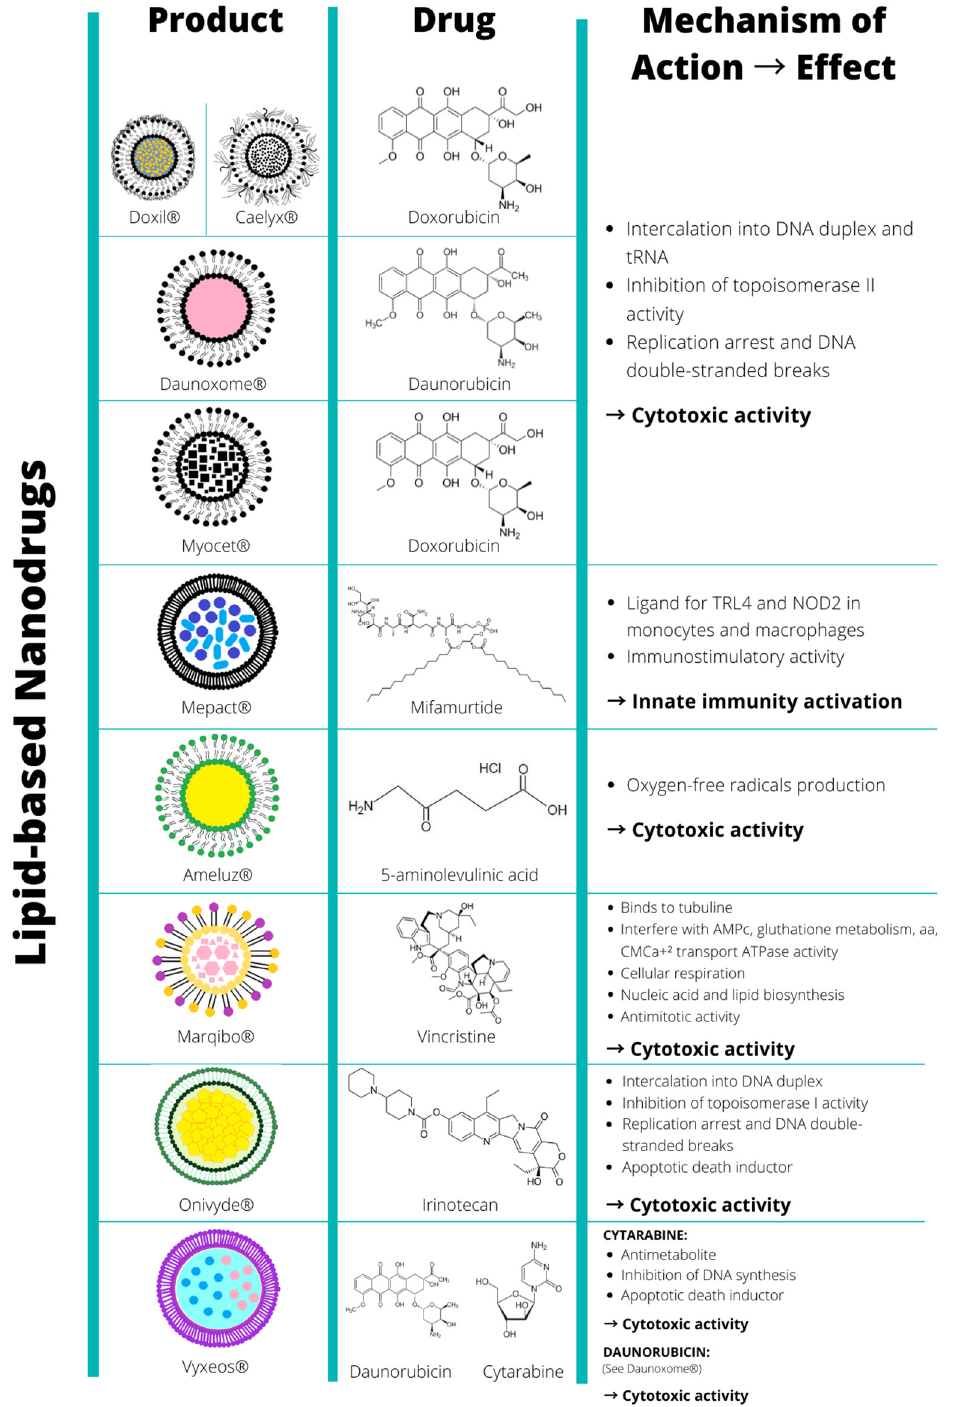
Figure 1. Lipid-based approved and marketed nanopharmaceuticals FDA and/or EMA-approved nanomedicines from 1995 to 2022 (last accessed May 2022), cataloged by their nature, encapsulated drug, their mechanism of action, and their induced effects. Doxil TM and Caelyx TM are indicated for the treatment of ovarian cancer, AIDS-related Kaposi’s sarcoma, and in combination with bortezomib, for the treatment of multiple my- eloma. Caelyx TM and Myocet TM are also indicated for patients with metastatic breast cancer [78].